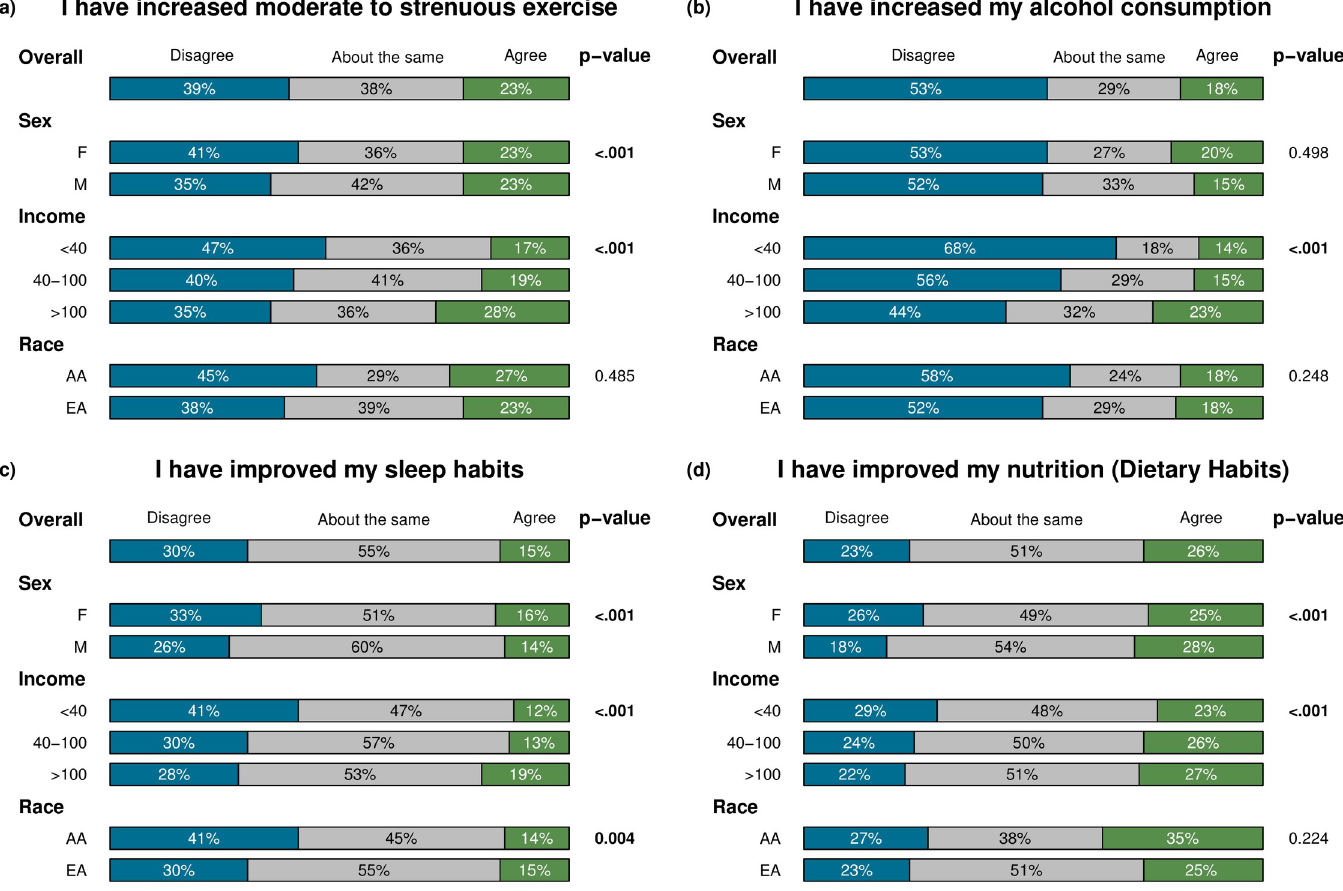
Fig 5. Behavioral change by sex (Female versus Male), income ( < $40,000 versus $40,000–100,00 versus > $100,000 annual house income), and race (African versus European American).